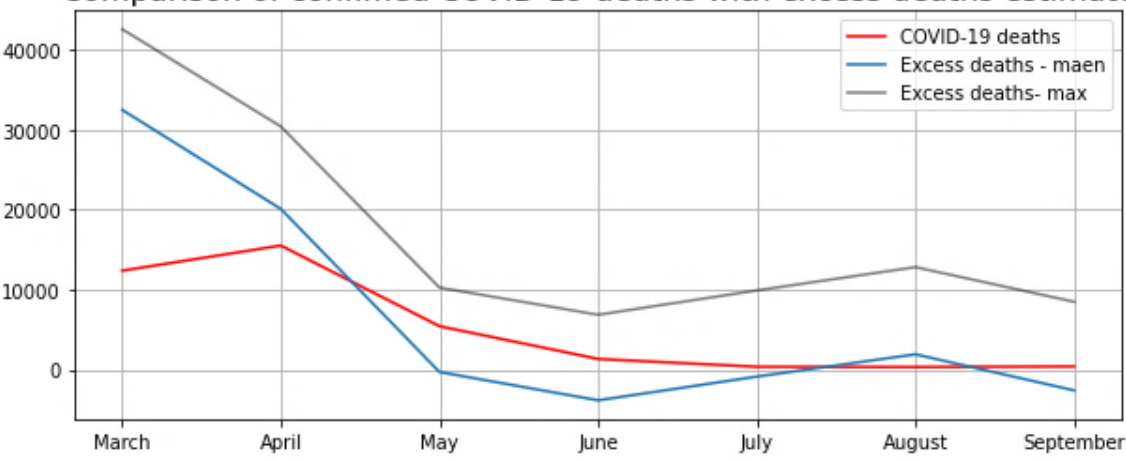
Figure 17. Estimate of excess deaths compared with officially registered COVID-19 deaths from March 2020 to September